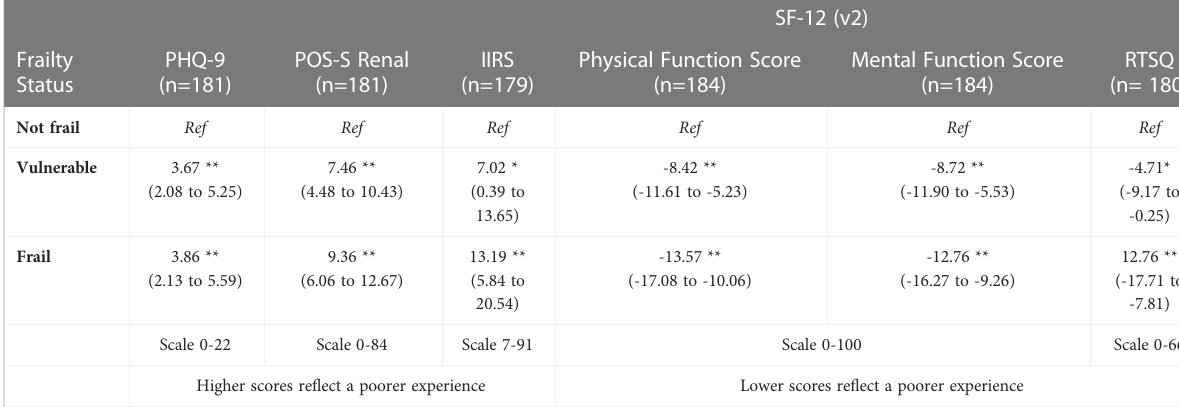
Resultsarepresentedasthecorrelationcoef fi cients(con fi denceinterval)describingthechangeinquestionnairescorebetweenthefrailtystatuseswhencomparedto ‘ notfrail ’ asthereference group, adjusted for age, gender and comorbidity burden. *p value = <0.05, ** p value = <0.001, Ref – reference group,PHQ-9 – Depression Patient Health Questionnaire, 9,POS-S Renal – Palliative Care Outcome Scale - Symptoms Renal, IIRS – Illness Intrusiveness Ratings Scale, SF-12 (v2) – Short-Form- 12 (version 2), RTSQ, Renal Treatment Satisfaction